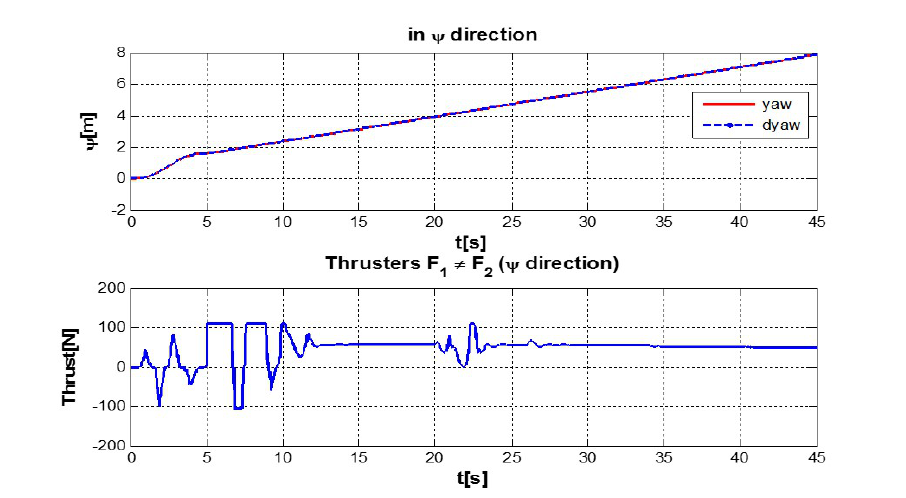
Figure 8. Behavior of the system in ψ -coordinate with perturbations up and (down) control signal of thruster F 1 (cid:54) = F 2.